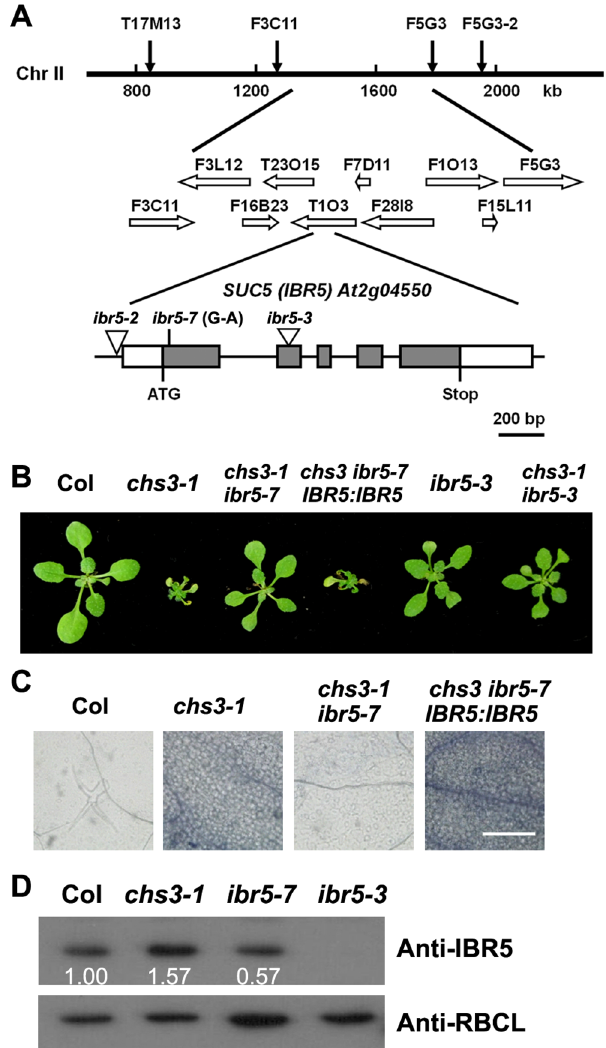
insertions are shown. (B) Morphology of the wild-type, chs3-1 , chs3-1 ibr5-7 , complemented transgenic plants ( IBR5 : IBR5 chs3 ibr5-7 ), T-DNA insertion mutant ( ibr5-3 ) and chs3-1 ibr5-3 double mutant.